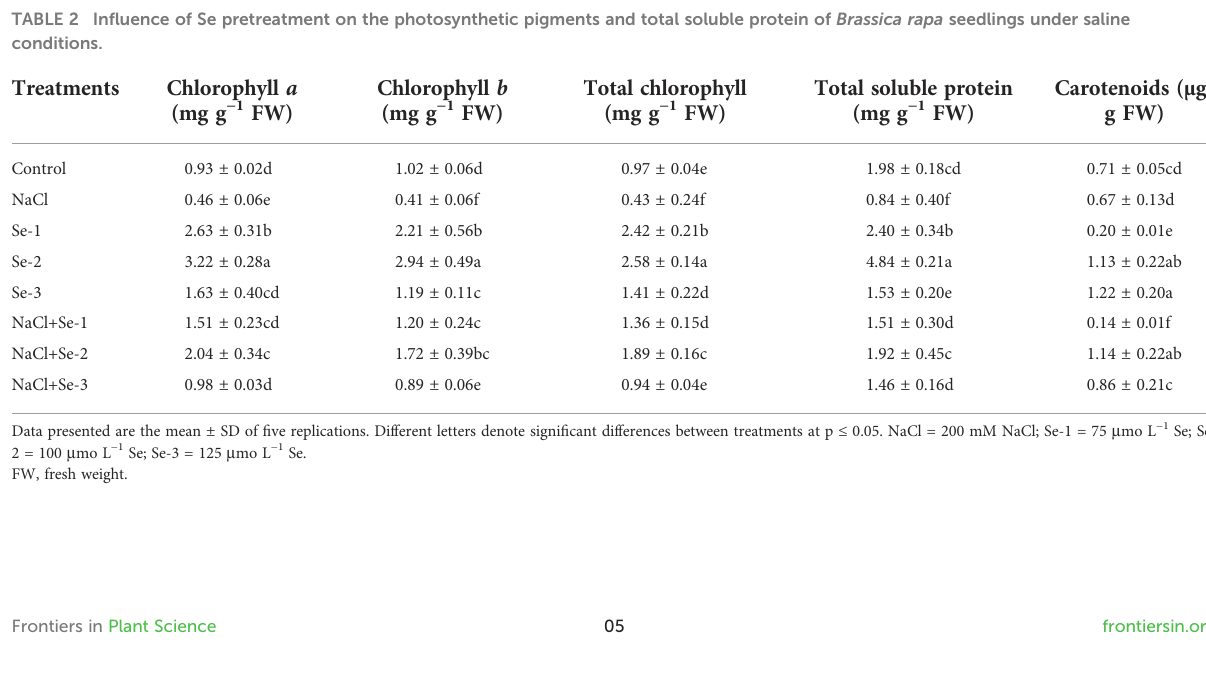
TABLE 2 In fl uence of Se pretreatment on the photosynthetic pigments and total soluble protein of Brassica rapa seedlings under saline conditions. Treatments